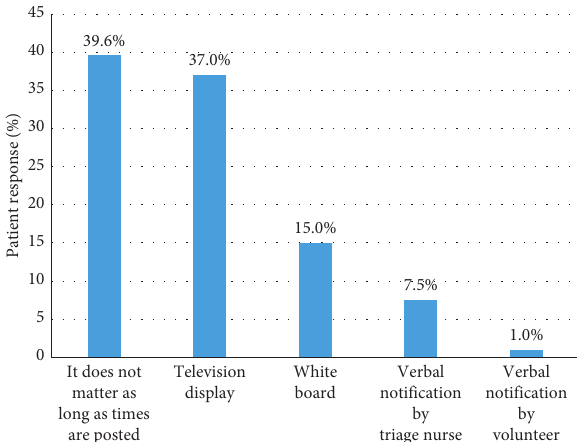
Figure 2: Patient number one ranked preference for modality of wait time publication in ED waiting room ( N �